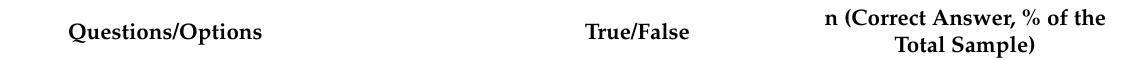
Table 2. Knowledge about COVID-19 among 440 Brazilian